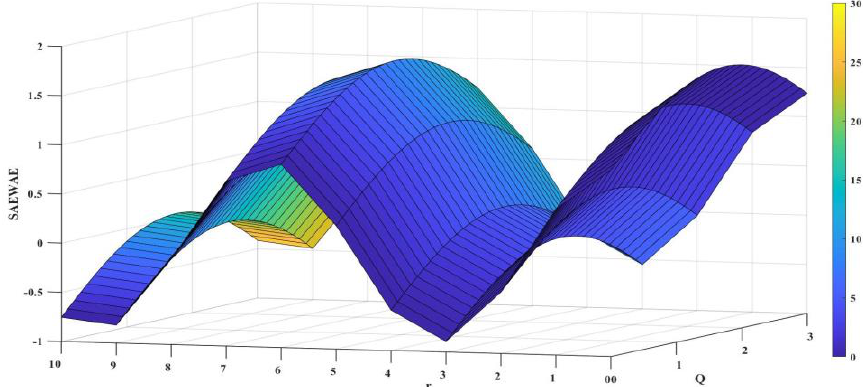
Figure 8. ( a ) Ensemble Empirical mode decomposition (EEMD) of HIF signal ( b ) Hilbert transform of IMF 3.